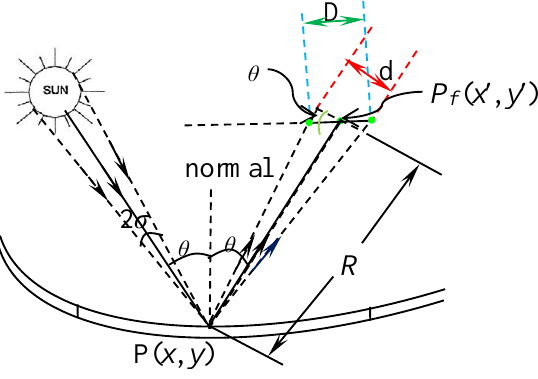
Figure 8. While the solar beam is actually a cone beam with a solid angle of 32′, the focus spot will be extended. Table 1. The parameters of aspheric reflectors whose vertices are located at di ff erent positions obtained with the particle swarm optimization